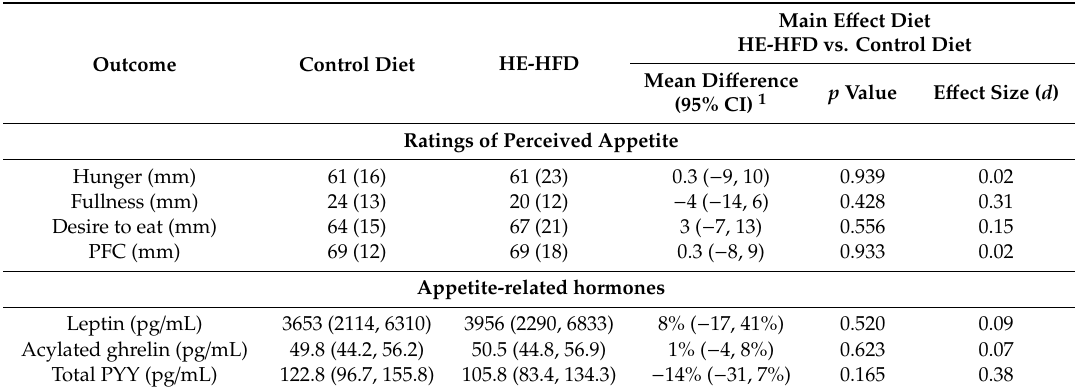
Table 1. Pre-diet fasted ratings of perceived appetite and appetite-related hormone concentrations during the control diet and hyperenergetic high-fat